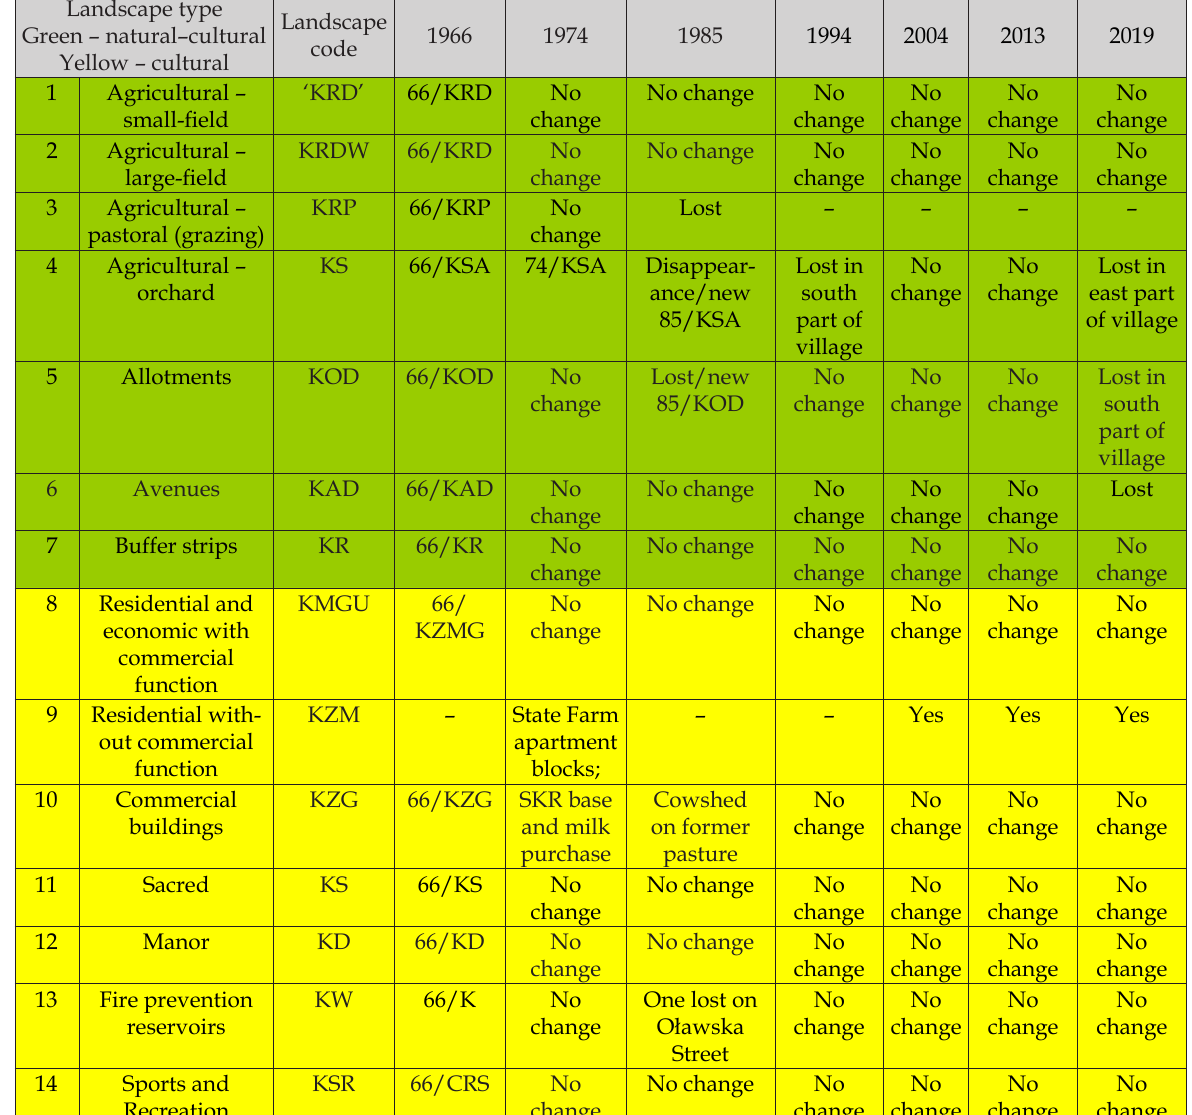
Table 1. Landscape transformations within the rural area of Borek Strzeliński for Fig.